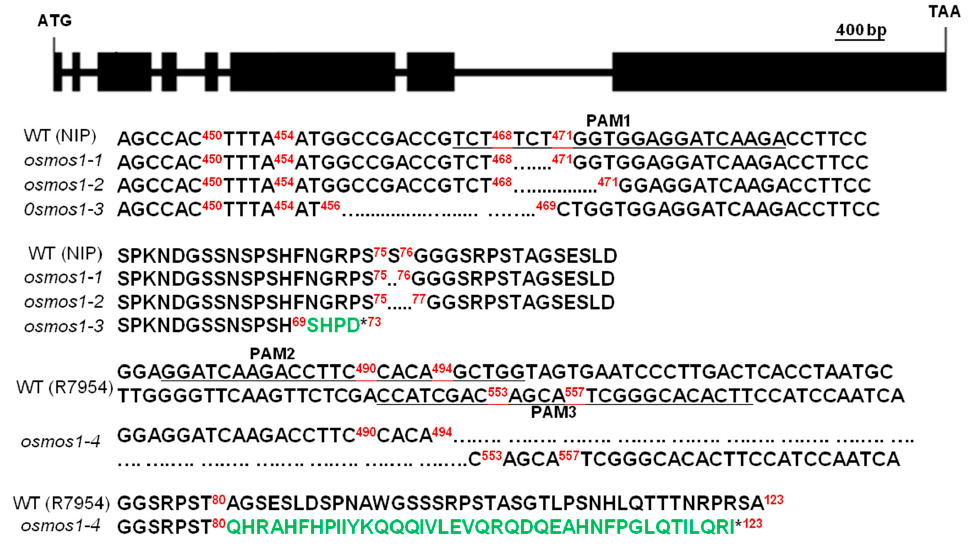
Figure 3. Mutants of OsMOS1 generated by CRISPR/Cas9 technology. Diagram of the genomic region and mutations of OsMOS1. The top diagram is the gene structure of the OsMOS1 genomic sequence. Exons and introns are indicated by black boxes and lines between boxes, respectively. The bottom panel shows the sequence alignments between the mutants and wild type with the genomic sequences above and the protein sequence below. The dotted line indicates the deletion of a base pair or amino acid sequence, green capital letters indicate amino acid missense mutations, * sign indicates a generated stop codon, and PAM indicates the protospacer adjacent motif.